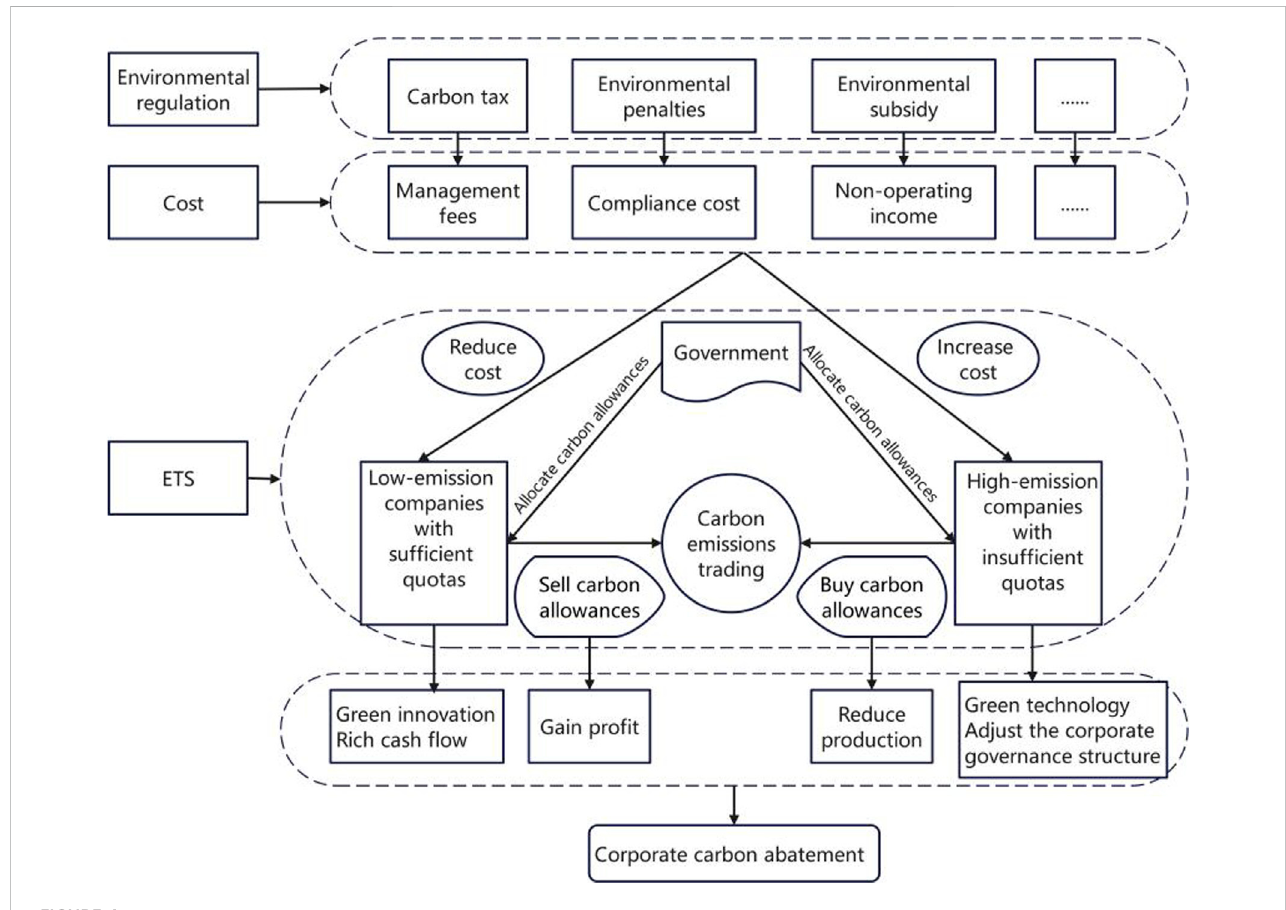
FIGURE 4 Corporate carbon emissions reduction